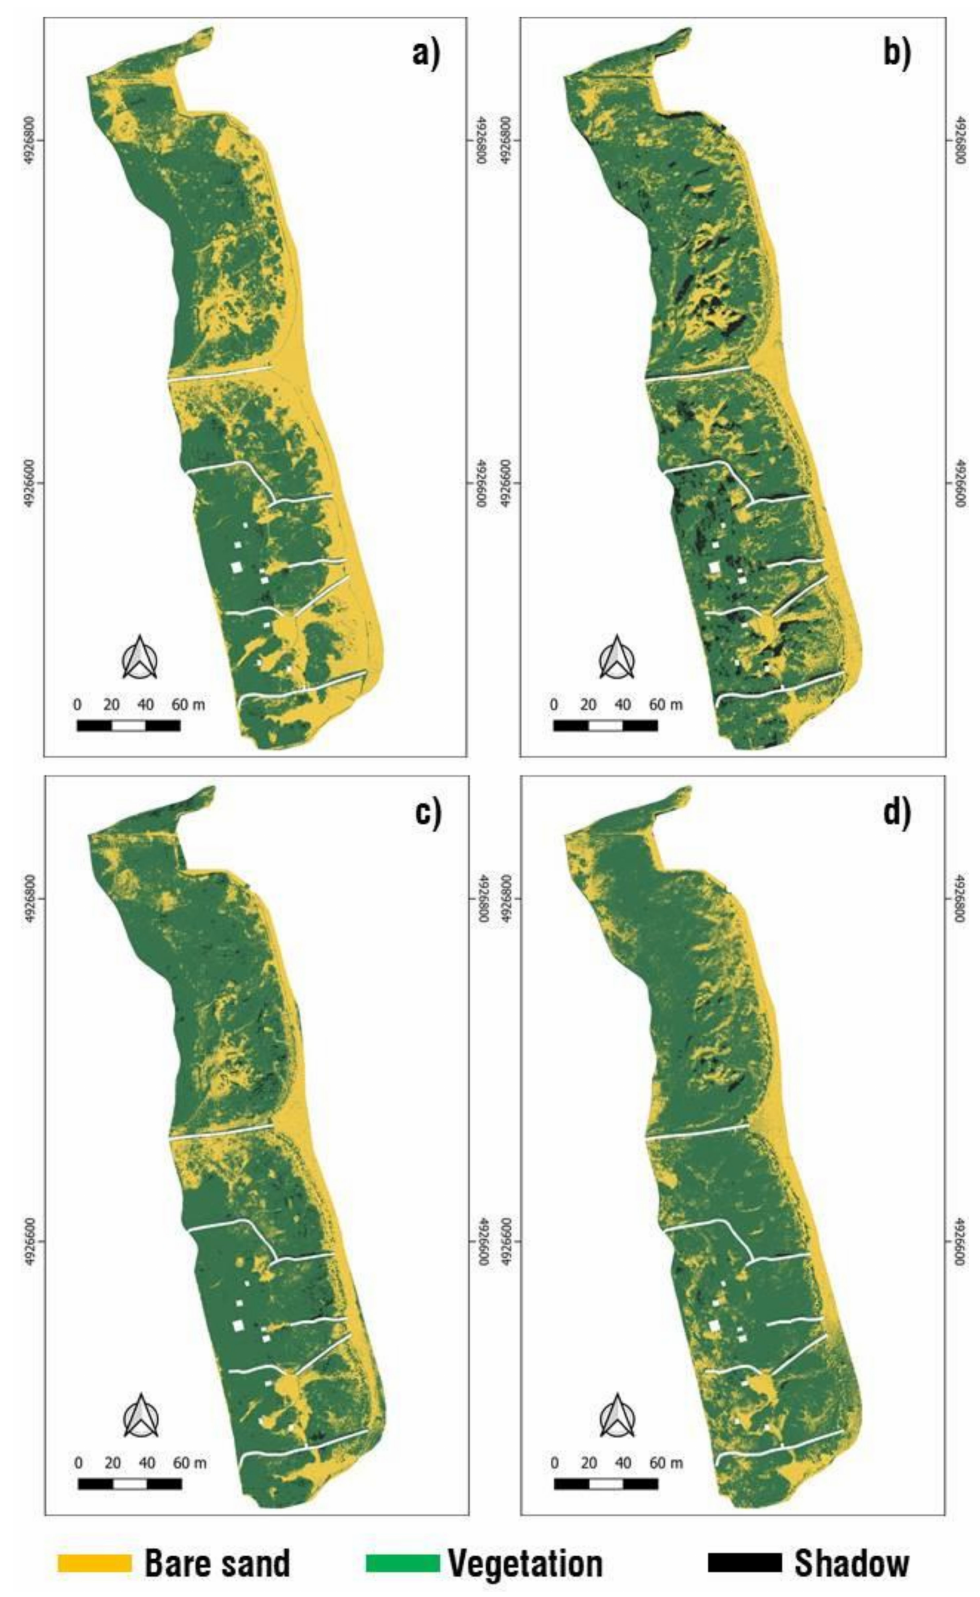
Figure 7. Semiautomatic classification maps; ( a ) March 2017, ( b ) December 2017, ( c ) April